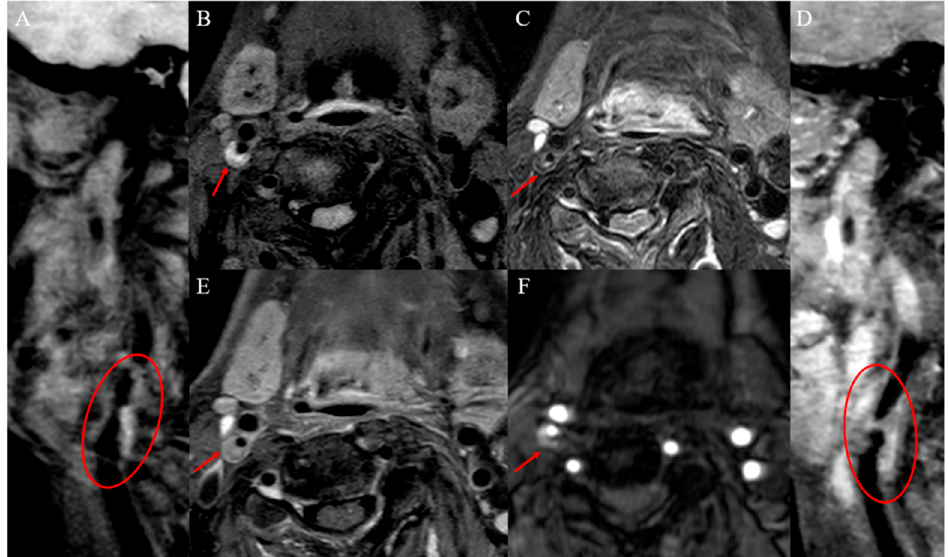
Figure 1. Definition of vulnerable carotid plaque (IPH and incomplete fibrous cap). Pre-enhanced VW-HRMRI 3D T1WI ( A , B ): inhomogeneous hyperintensity in the plaque and plaque surface was not smooth. T2WI-SPAIR image ( C ): hypointensity in the plaque. Post-enhanced VW-HRMRI 3D T1WI ( D , E ): discontinuous thin-linear enhancement on plaque surface. TOF image ( F ): hyperintensity in the plaque.